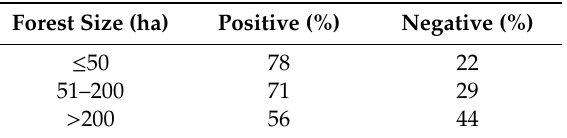
Figure 1. Forest owners’ willingness to conduct whole-three harvesting in early thinning for three different scenarios. Table 9. Percentage of FFOs with positive and negative attitudes to towards whole-tree harvest at thinning according to size of their forest.